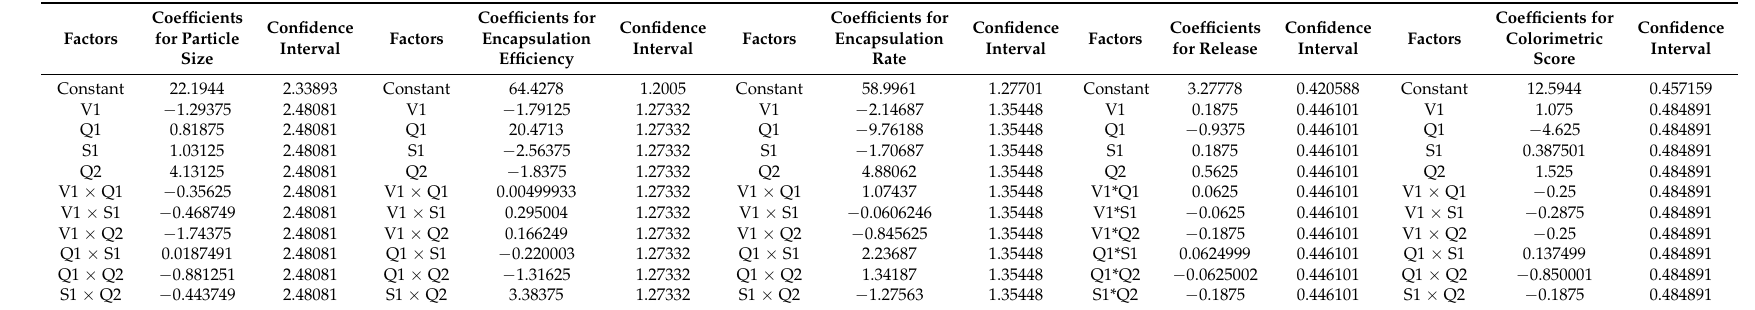
Figure 4. Coefficients’ weights for all responses. Table 3. Coefficients’ model.